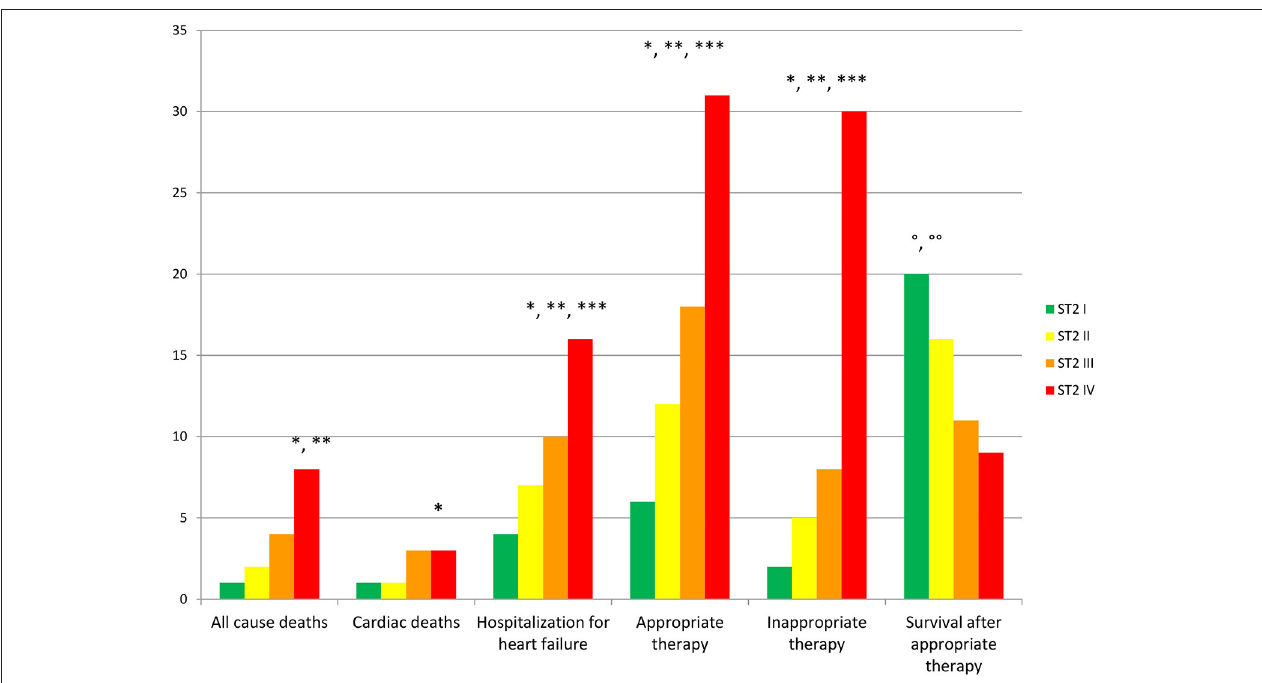
FIGURE 7 | In the right part of the figure study outcomes reported for ST2 quartiles (I, II, III, IV quartile) in ng/ml. In the y axis number of events for each ST2 quartile. In the x axis the study outcomes. In green color I ST2 quartile. In yellow II ST2 quartile. In orange III ST2 quartile. In red IV ST2 quartile. A p < 0.05 is marked with symbol: * if ST2 IV vs. ST2 I; ** if ST2 IV vs. ST2 III; *** if ST2 IV vs. ST2 II; ◦ if ST2 I vs. ST2 IV; ◦◦ if ST2 I vs. ST2 III.